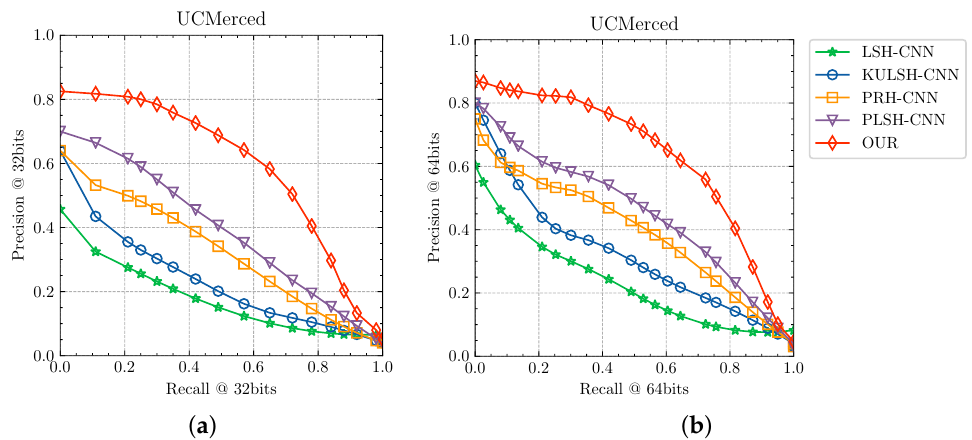
Figure 7. Precision-recall curves on the UCMD dataset. ( a ) Precision-recall curve@32 bits. ( b ) Precision- recall curve@48 bits.